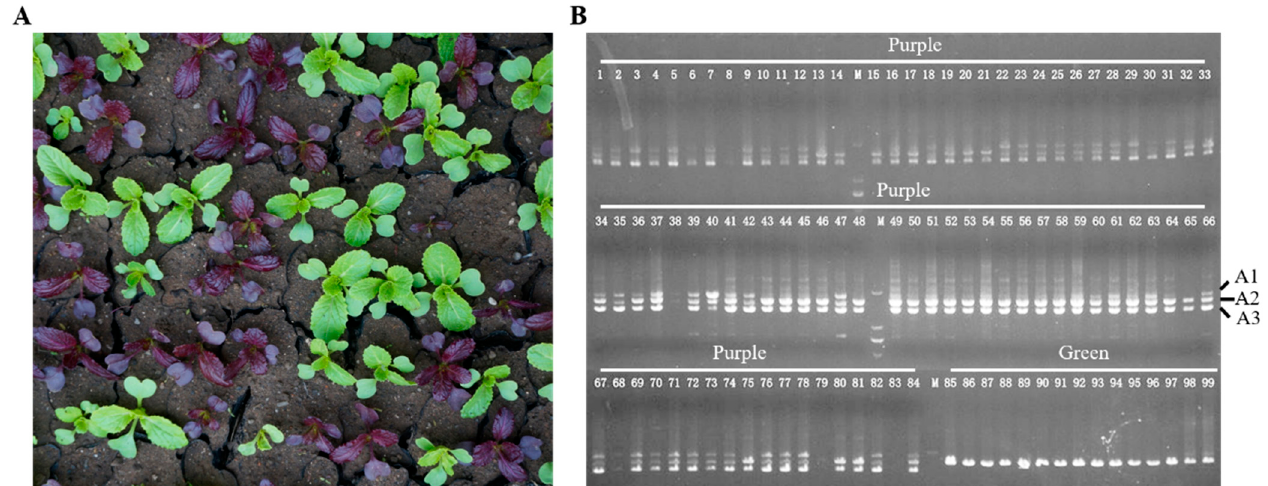
Figure 5. BjuB014115 is necessary for the purple color trait in 18M-245. The leaf color phenotype of the F2 separating population obtained by backcrossing 18M-245 with its green Chinese cabbage parent Jiao Eyra ( A ). Genotypes of the F2 population. A total of 84 purple leaf individuals (Nos. 1–84) and 15 green leaf individuals (Nos. 85–99) were used for genotype identification. The 1036 bp A3 band corresponds to BjuB014115 and was displayed in the purple individuals only, suggesting that the purple trait is tightly associated with the monosomic chromosome addition line derived from B05 ( B ).